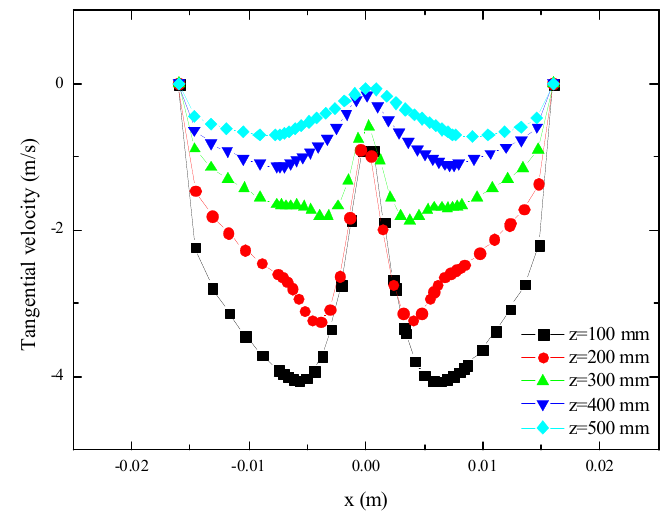
Figure 16. Radial distribution of tangential velocity at different positions in the inner cylinder.